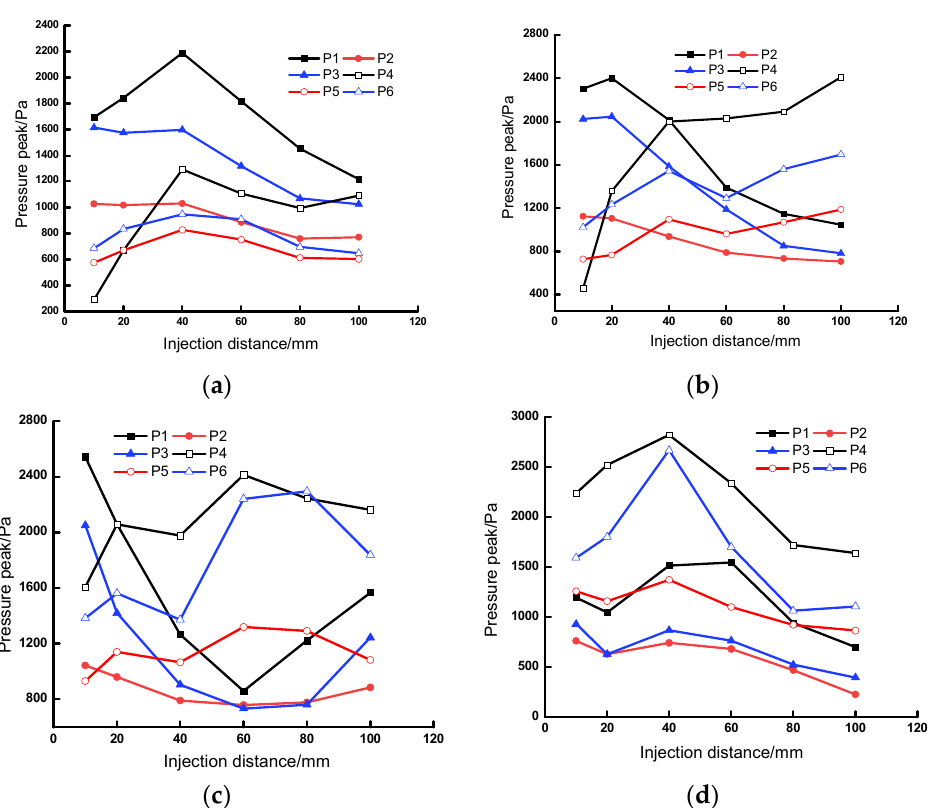
Figure 4. The change of the peak pressure on the sidewalls with different nozzle areas at different jet distances at the pulse pressure of 0.3 MPa. ( a ) Total nozzle area of 273 mm 2 . ( b ) Total nozzle area of 546 mm 2 . ( c ) Total nozzle area of 819 mm 2 . ( d ) Total nozzle area of 1365 mm 2 .